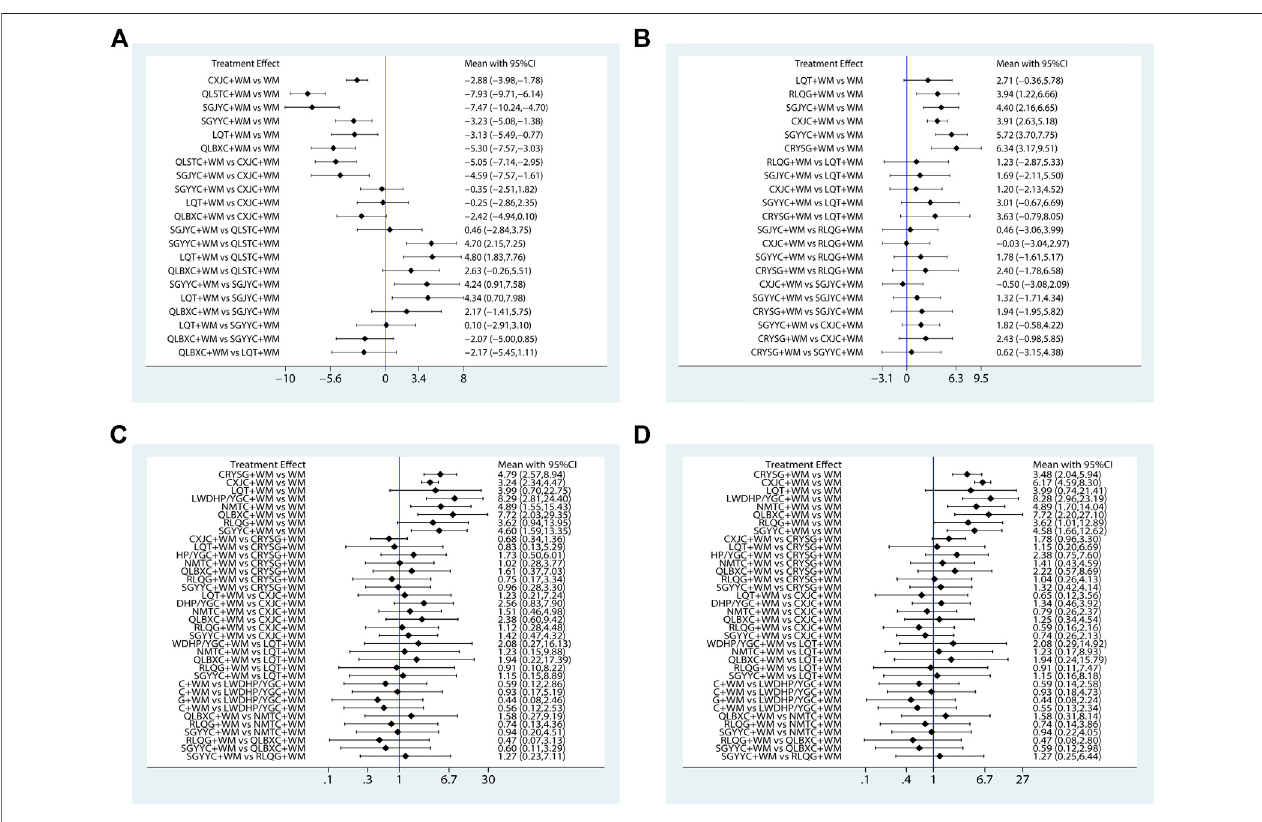
FIGURE 5 | Forest graphs of Meta-analysis (A) NIH-CPSI; (B) IIEF-5; (C) the clinical effective rate of CP/CPPS; (D) the clinical effective rate of SD.